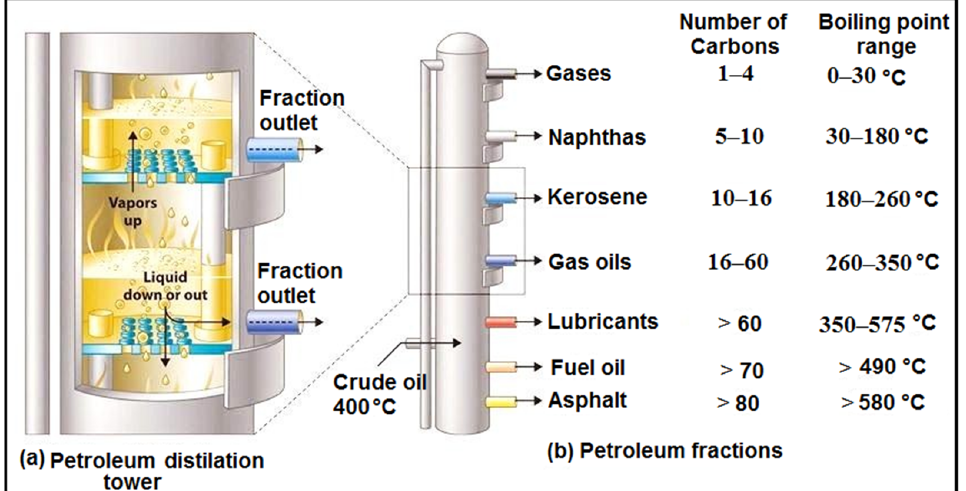
Figure 1. Boiling point distribution and chemical distribution of crude oil components.